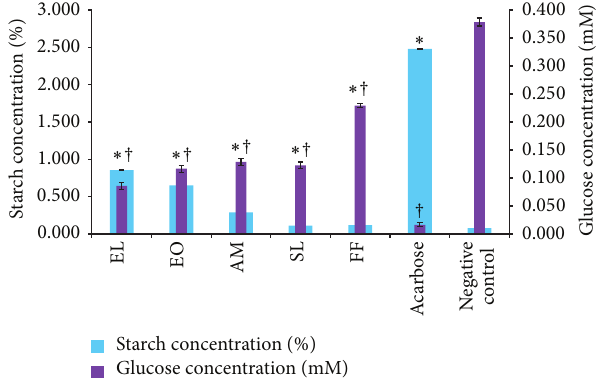
Figure 1: Effect of methanolic plant extracts (160mg crude extract/mL) on glucose diffusion.